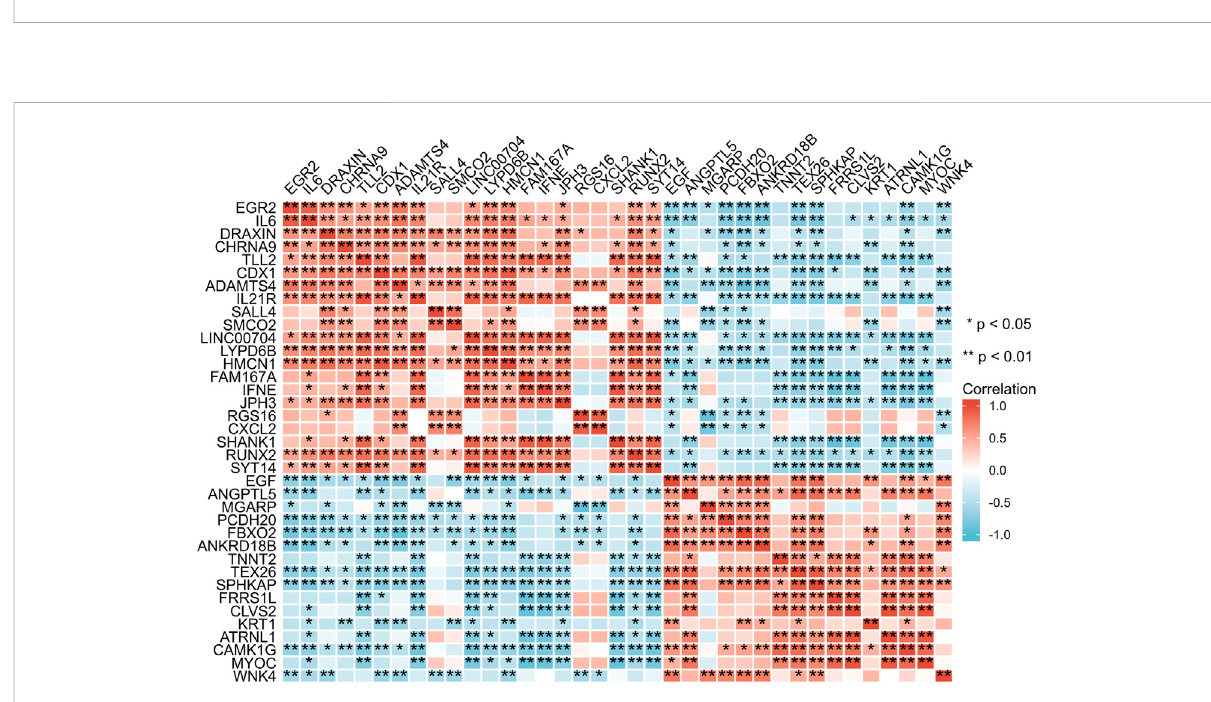
FIGURE 6 Spearman correlation analysis of the 37 differentially expressed